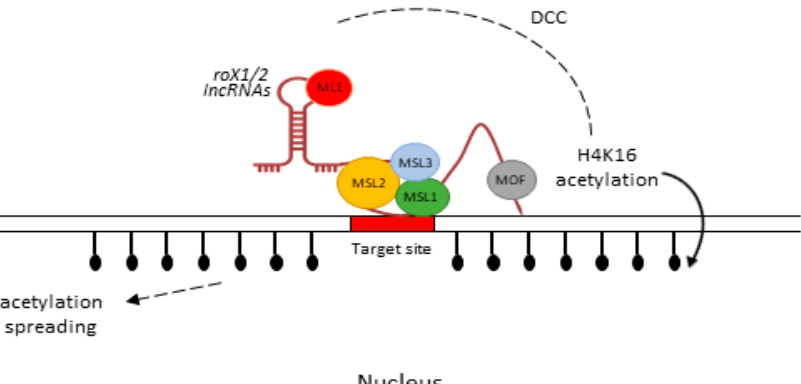
Figure 3. Regulatory role of roX1/2 lncRNAs on the X chromosome of male Drosophila . Two lncRNAs and five male-specific lethal (MSL) proteins form a dosage compensation complex (DCC) [66]. The DCC is established and extends to the target site via diffusion. MLE is responsible for RNA/DNA helicase and ATPase activity [101]. MSL1/MSL2 identify the target site and MOF initiates the H4K16ac, spreading this chromatin modification over numerous kilobases [65].